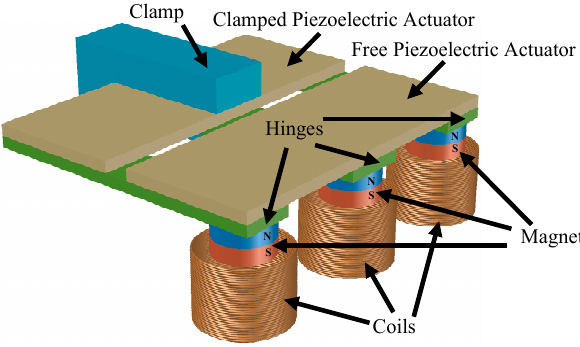
Figure 12. Schematic representation of the piezoelectric actuators based MTT proposed in [23,24].